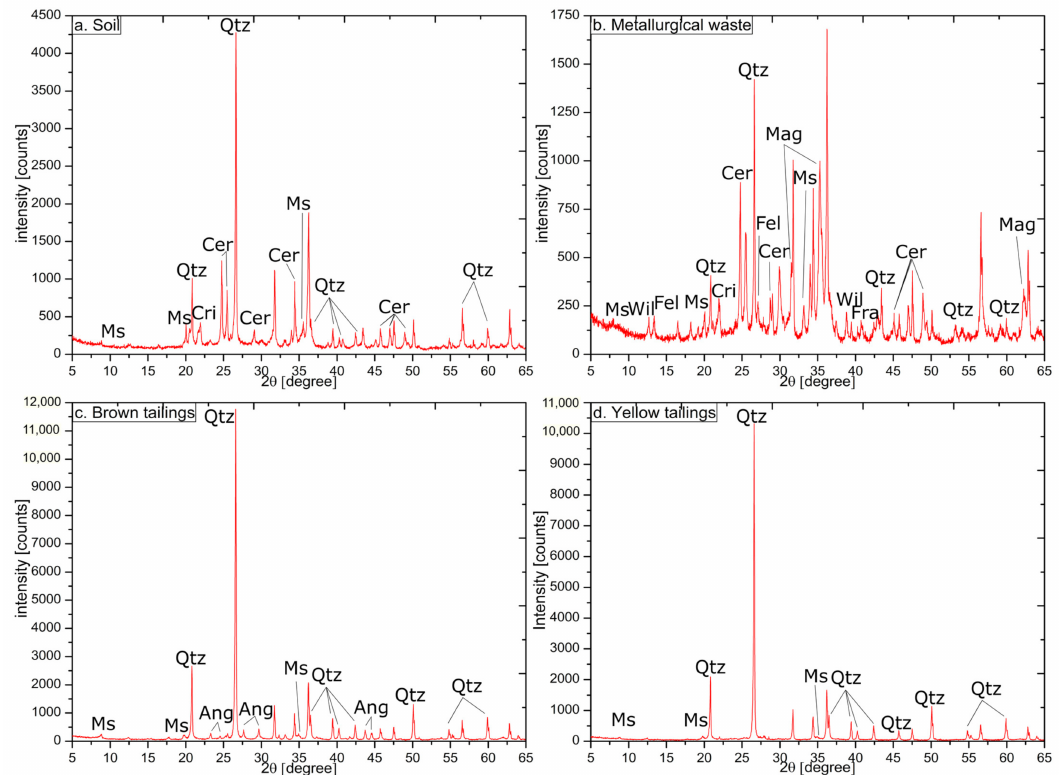
Figure 9. Diffraction spectra of the different mine waste material samples: ( a ) soil, ( b ) metallurgical waste, ( c ) brown tailings, ( d ) yellow tailings. Qtz—quartz, Ms—muscovite, Fel—feldspars, Cer—cerussite, Ang—anglesite, Cri—cristobalite, Fra— Franklinite, Wil—Willemite and Mag—magnetite. Peaks not marked are zincite, which was used as an internal